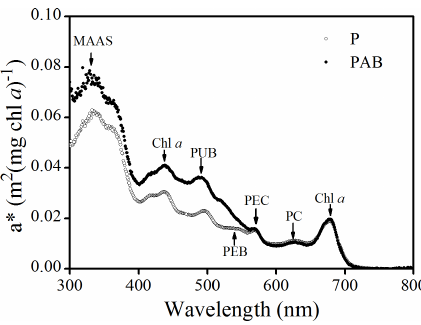
Figure 5. Chl a -specific absorption spectrum ( a ∗ ) of Tri- chodesmium IMS101 grown under solar PAR (P) and PAR + UVA + UVB (PAB). The measurements were taken on the 18th day. The absorption peaks of MAAs (330nm), PUB (495nm), PEB (545nm), PEC (569nm), PC (625nm), and Chl a (438 and 664nm) are indicated.